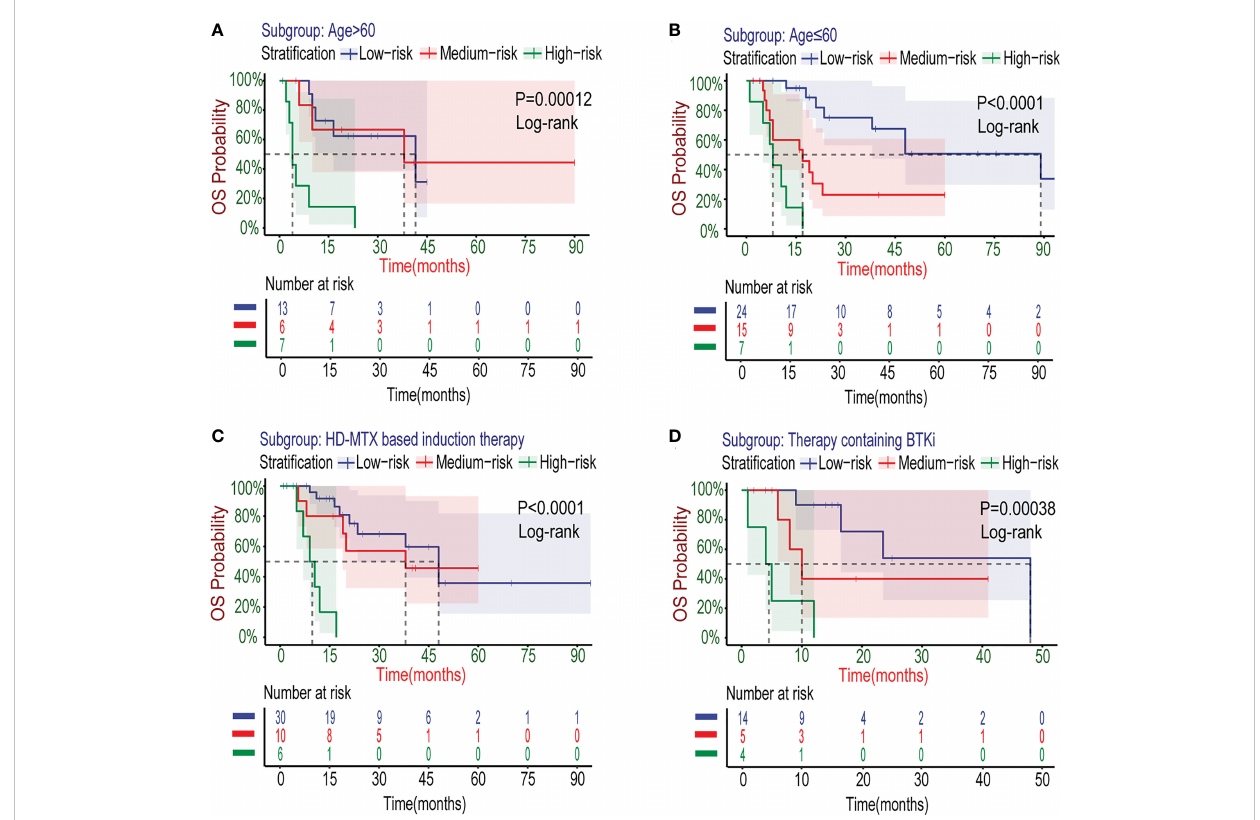
FIGURE 6 Kaplan – Meier survival curves of speci fi c subgroups strati fi ed by the Xijing Model in the development cohort. The OS curves for subgroups with different characteristics of age (A, B) and therapy (C, D) were displayed.